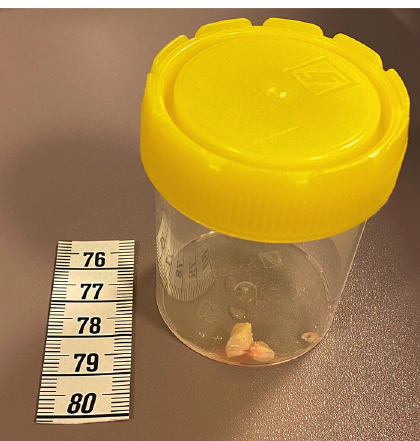
Figure 2: Follow-up chest X-ray 12h after arrival. The left lung is completely atelectatic, and the mediastinum has shifted to the left.